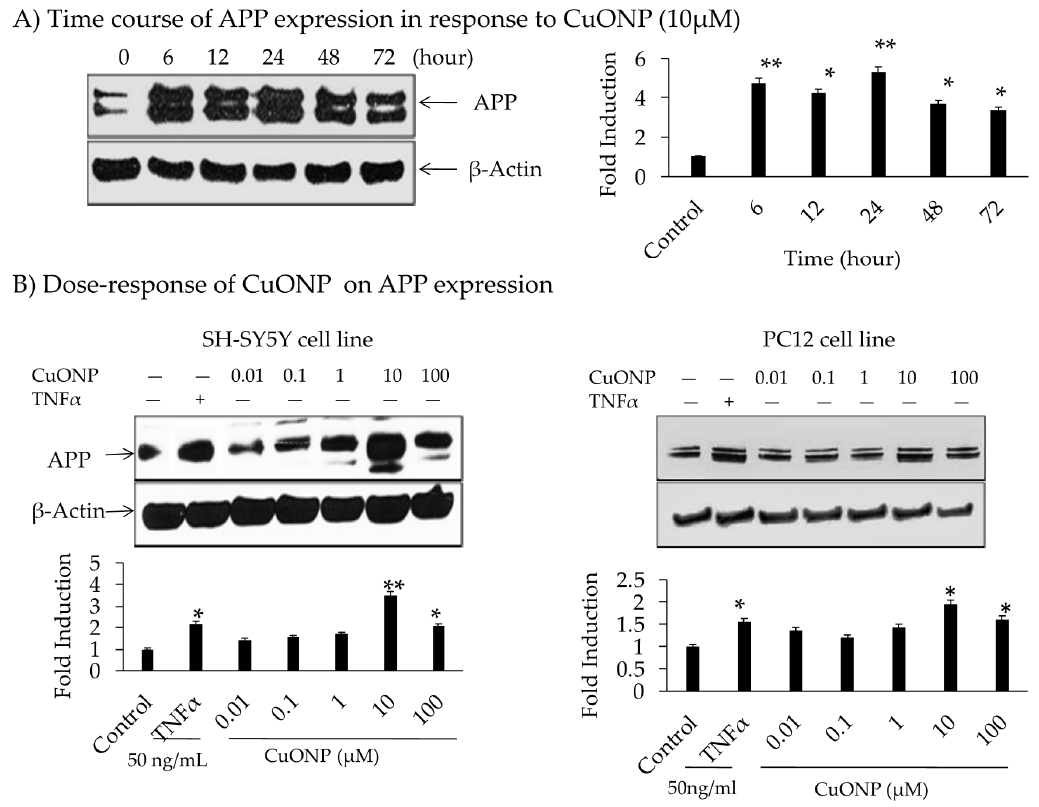
Figure 3. Effect of CuONPs on amyloid precursor protein (APP) expression. ( A ) Time course of APP expression in response to CuONPs (10 μ M); ( B ) dose 0–100 μ M, response of CuONPs on APP expression in SH-SY5Y cells (left) and PC12 cells (right). In ( A ), cells were harvested at the indicated time points and blotted for APP and β -actin. In ( B ), doses of CuONPs in the range (0–100 μ M ) and TNF α (50 ng /mL) were used and cells harvested at 6 h and lysates blotted for APP and β -actin. Densitometric analysis from 3 independent experiments were plotted and Student’s t-test were performed to determine levels of significance, * p < 0.05, ** p < 0.01 CuONPs or TNF α treated compared to control.